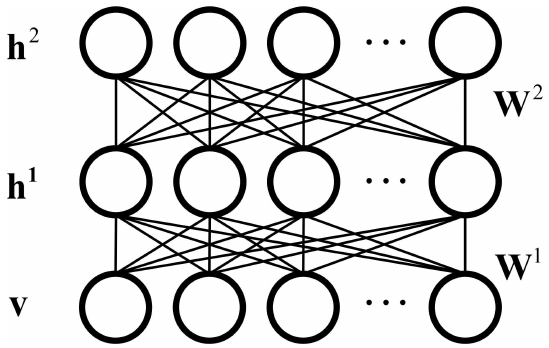
Figure 8. The three-layered Deep Boltzmann Machine used for shape prior